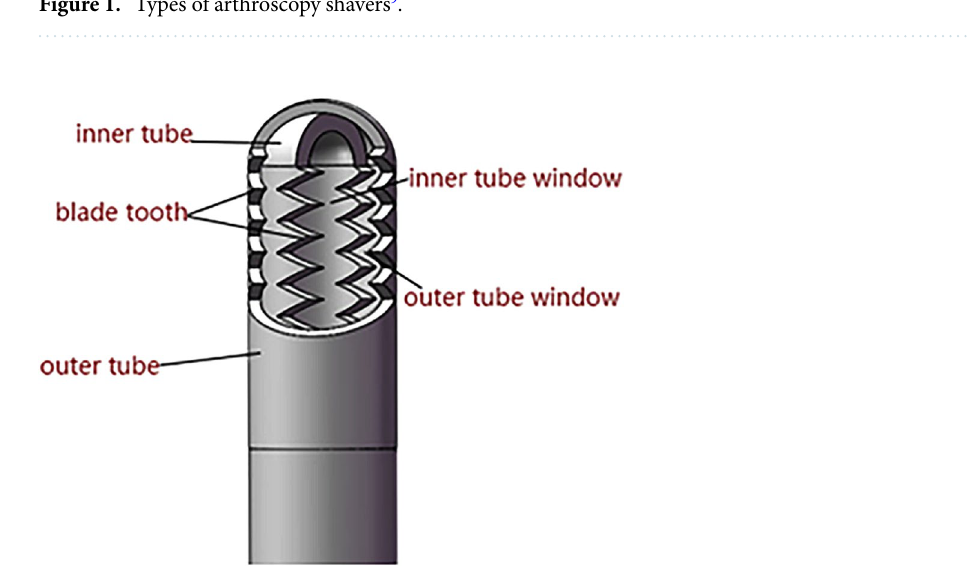
Figure 2. The Structural diagram of the shaver